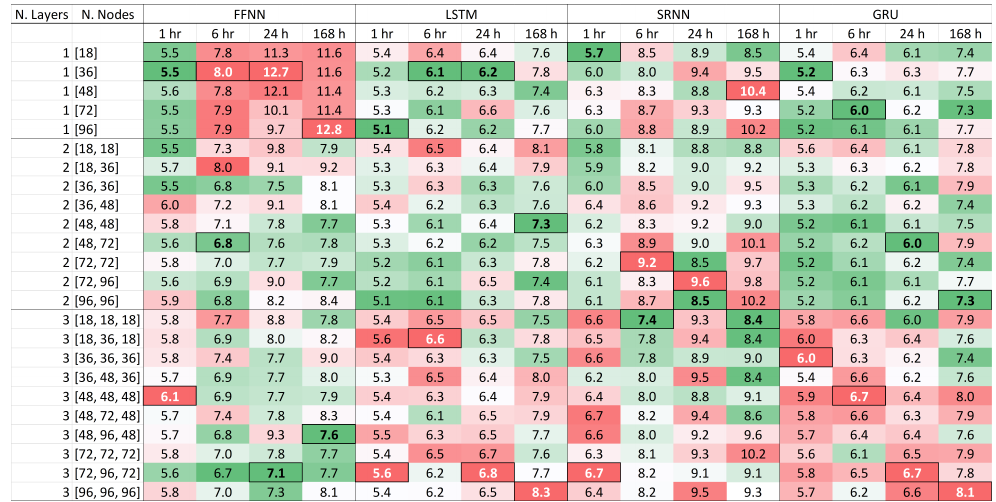
Figure 10. MAPE of the models of ts 2 time series for each architectures on the 4 forecasting horizons with the set of inputs